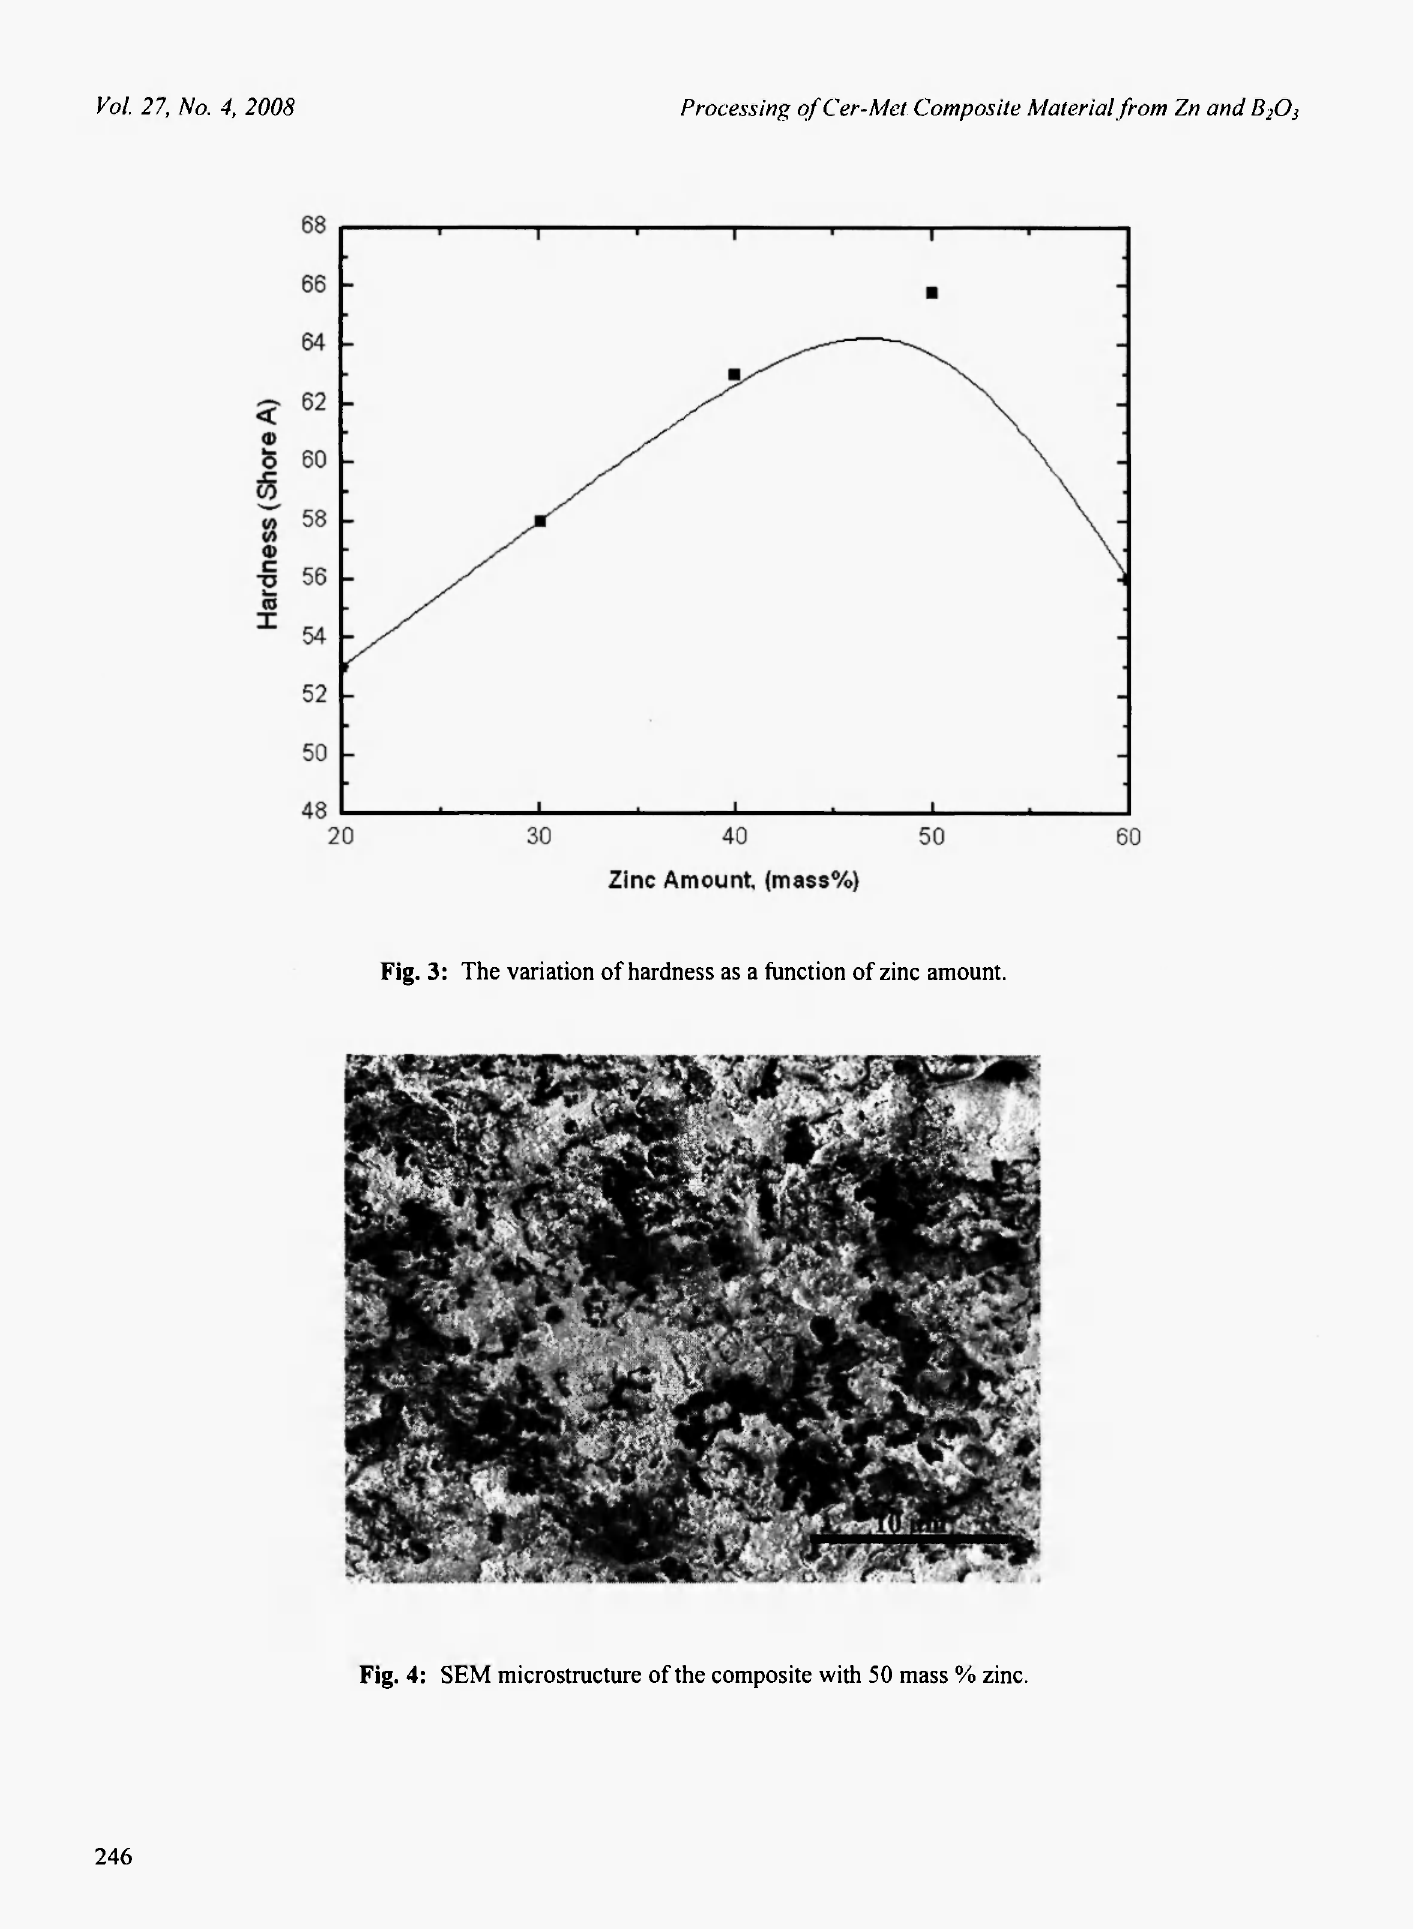
Fig. 4: SEM microstructure of the composite with 50 mass %